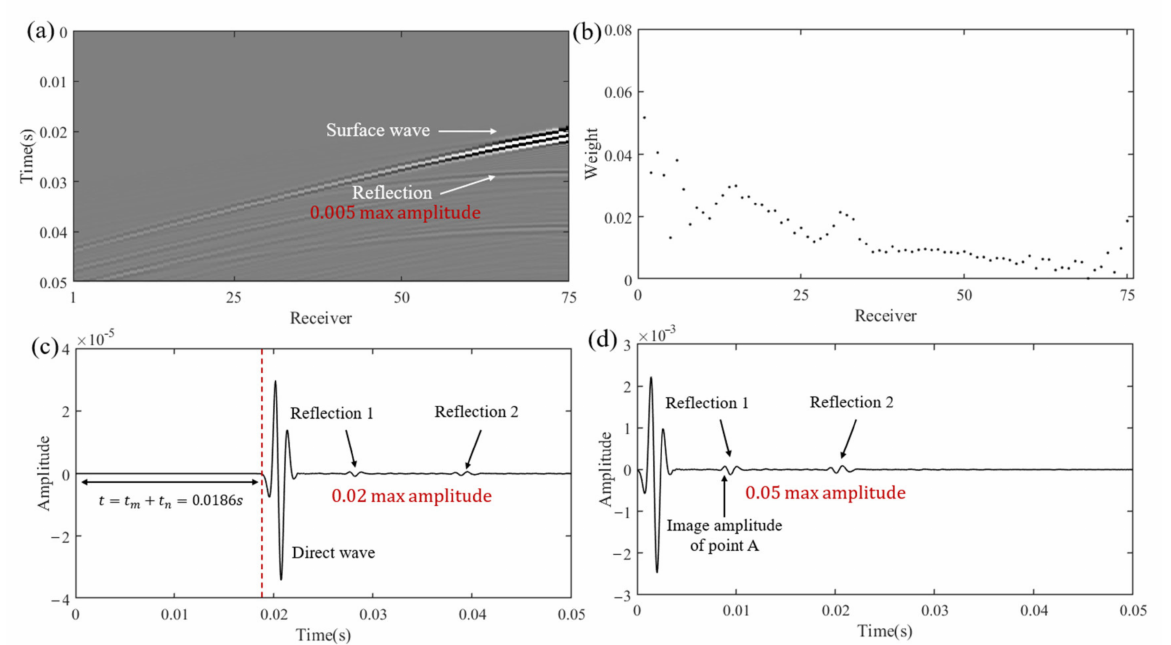
Figure 4. Delayed signal and weighted superposition of point A. ( a ) Delayed signal of the 1st subarray. ( b ) Weight of each receiver in the 1st subarray according to the MV method. ( c ) Superposed curve of weighted signals. ( d ) Amplitude curve on axis line x = x A .